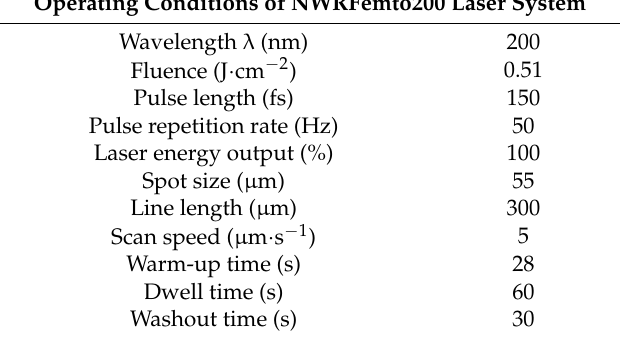
Table 1. Operating conditions of the femtosecond laser ablation-inductively coupled plasma-mass spectrometry (fs-LA-ICP-MS)